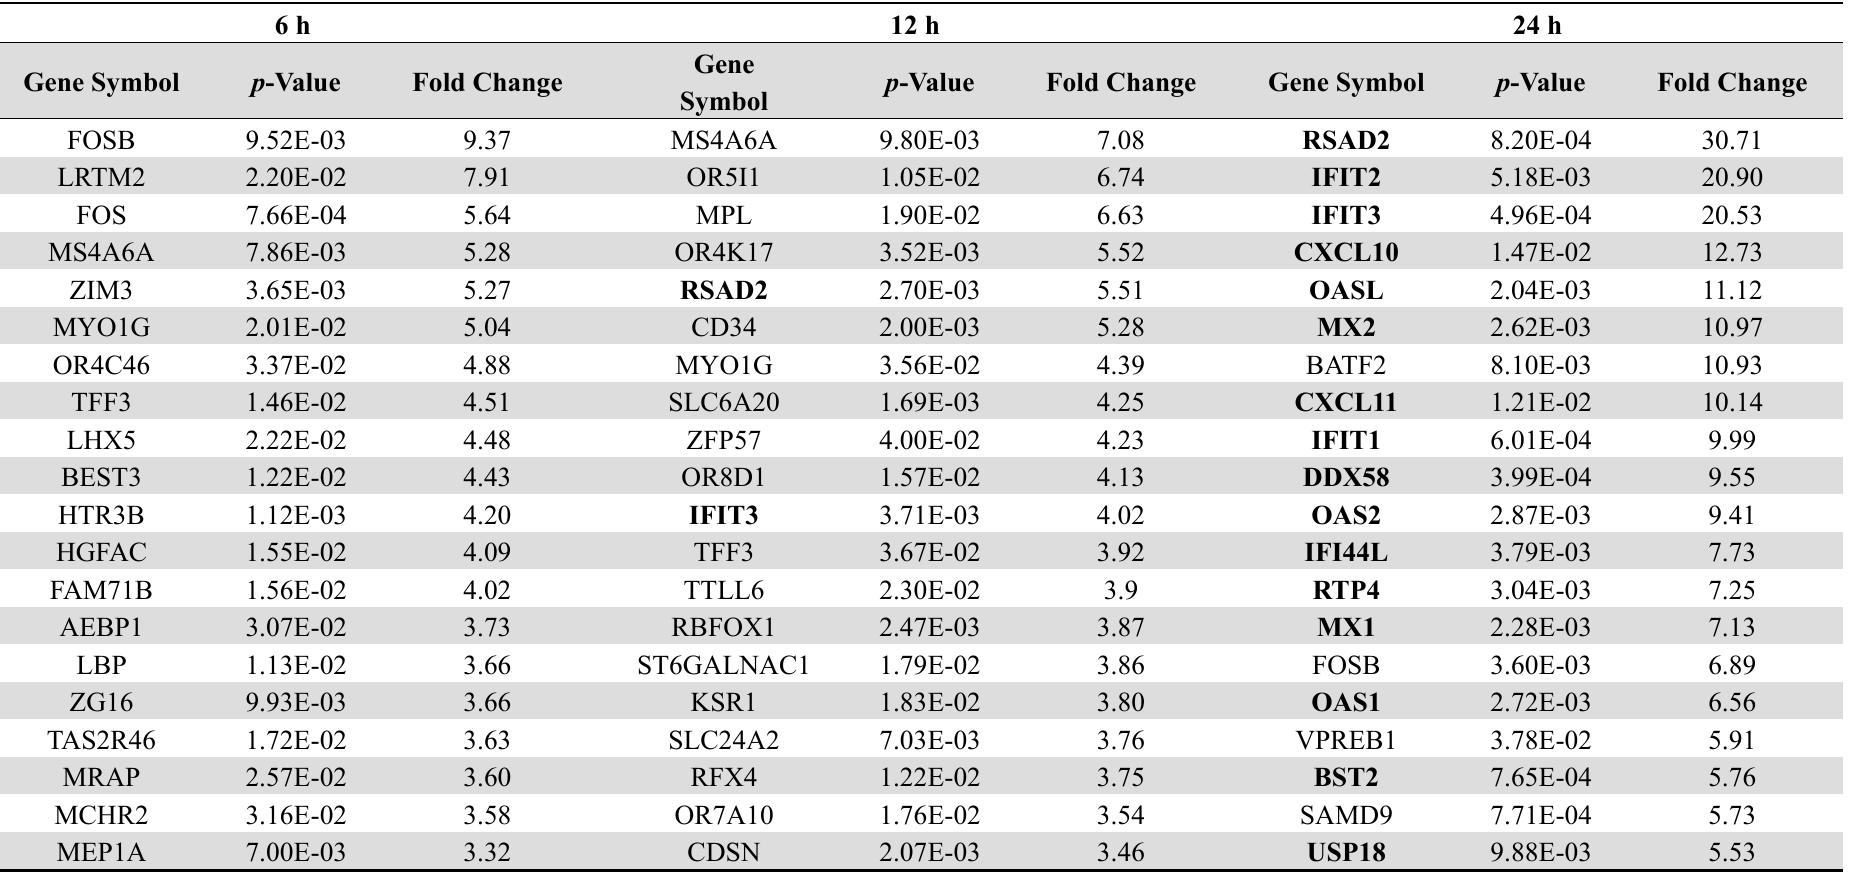
Table 1. The top 20 genes upregulated by HM/06 infection in U251 cells at each time. Genes in bold indicate